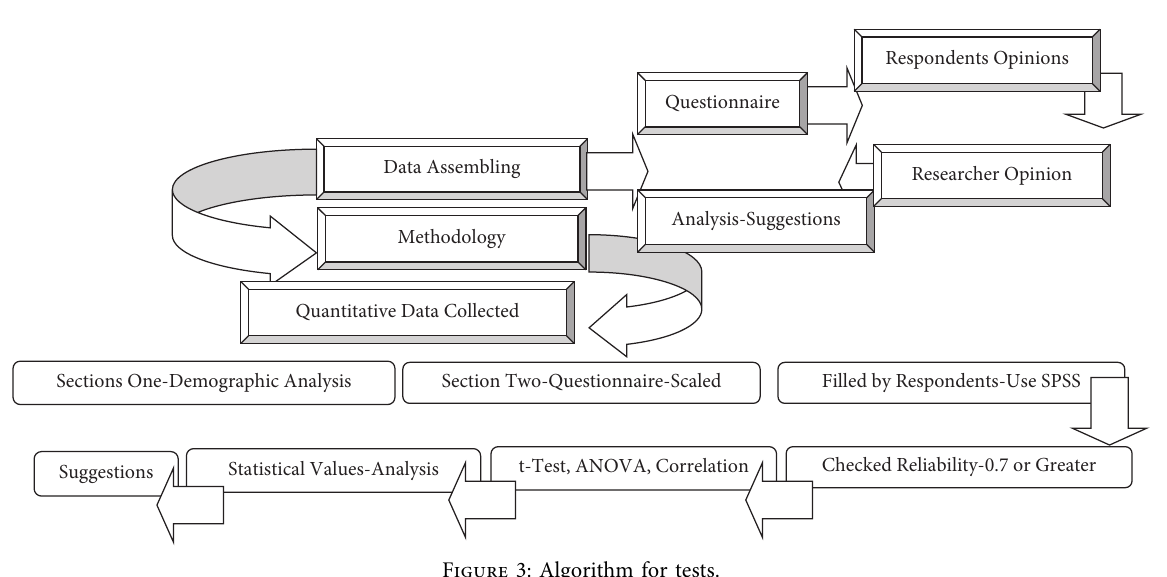
Figure 3: Algorithm for tests.